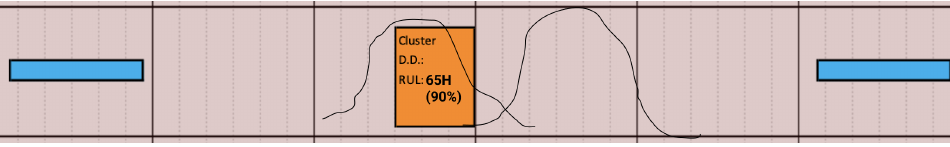
Figure 8. Proposed remaining useful life distribution visualization by Participant 1.